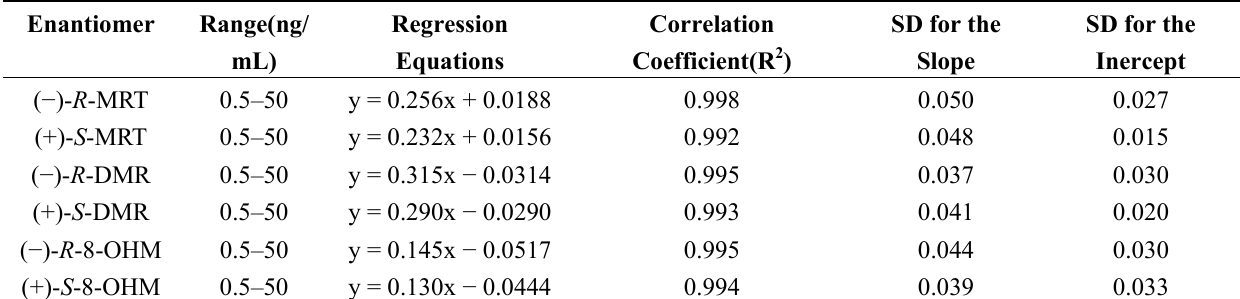
Table 2. Within-day precision and accuracy for the analysis of MRT, DMR and 8-OHM enantiomers in human plasma (n = 5).